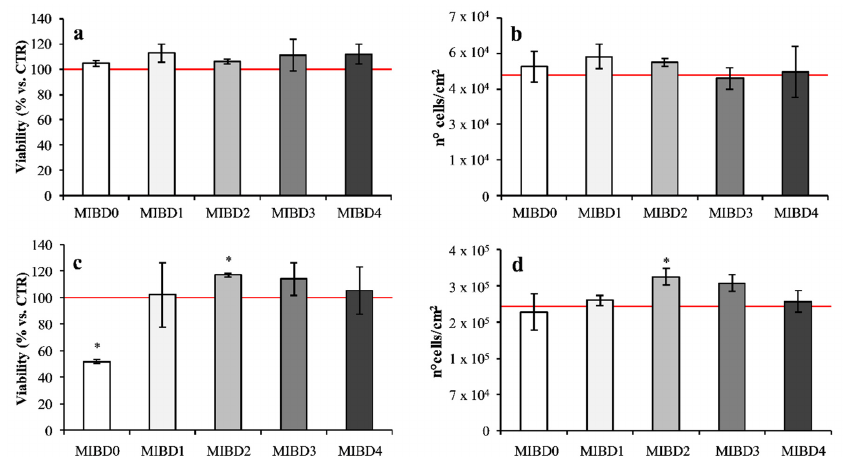
Figure 4. Viability and number of living human Saos-2 osteoblast-like cells after incubation with MIBDs. Viability and number of living cells were evaluated after three ( a , b ) and seven ( c , d ) days of cell incubation with 150 µg/cm 2 of each MIBDs. Each bar represents the mean from three independent experiments, each with at least two replicates. Asterisks indicate statistical differences ( p < 0.05) compared to CTR cells, indicated in the graph as a red line.